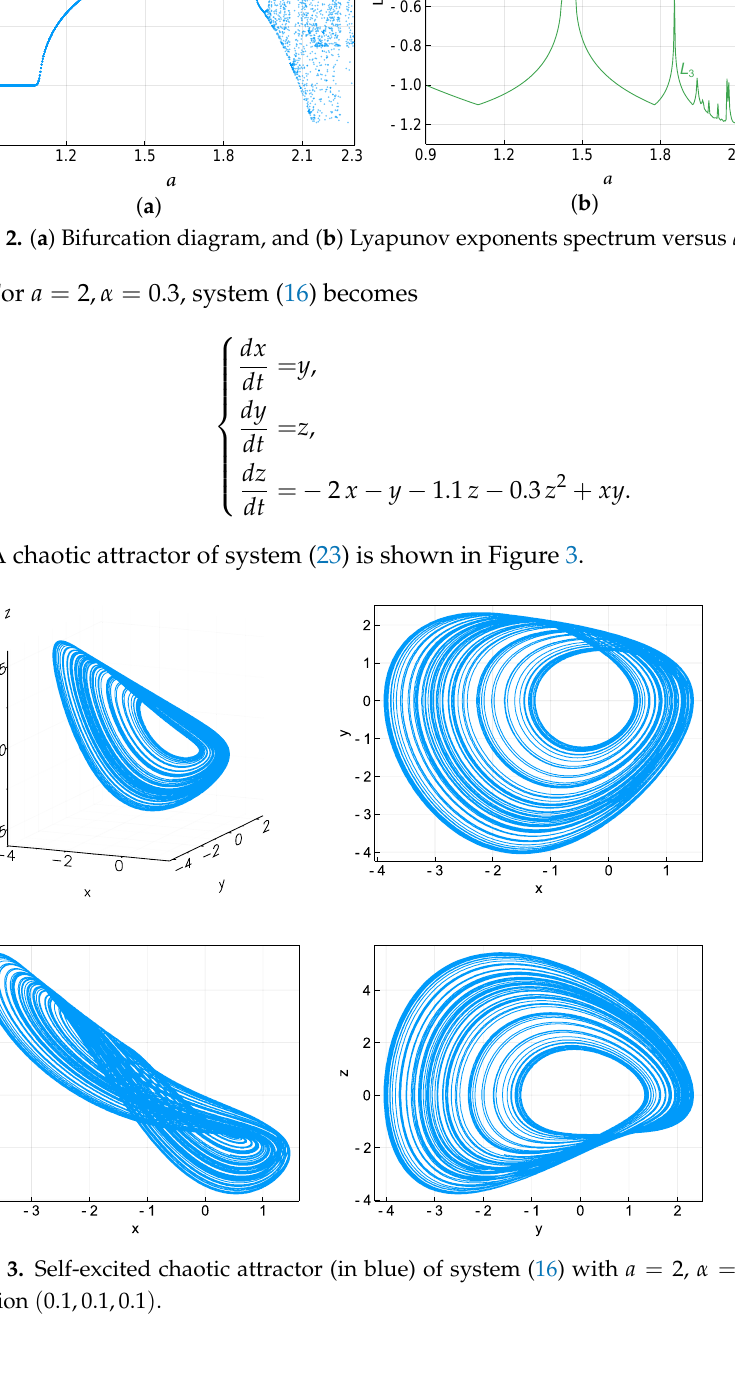
Figure 3. Self-excited chaotic attractor (in blue) of system (16) with a = 2, α = 0.3 for the initial condition ( 0.1,0.1,0.1 )